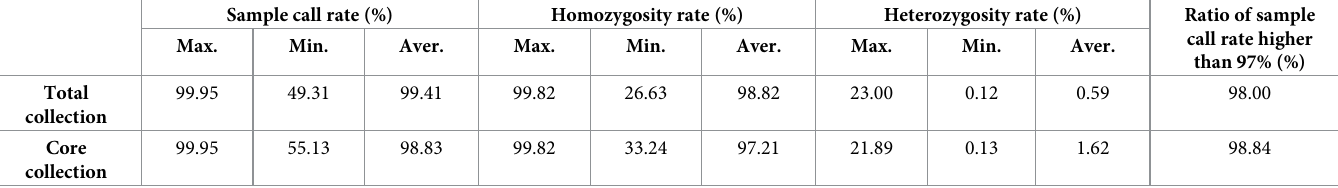
Table 1. Genotypic diversity of 2,872 accessions in the total collection and 430 accessions in the core collection by Axiom 1 180K SoyaSNP array. Sample call rate